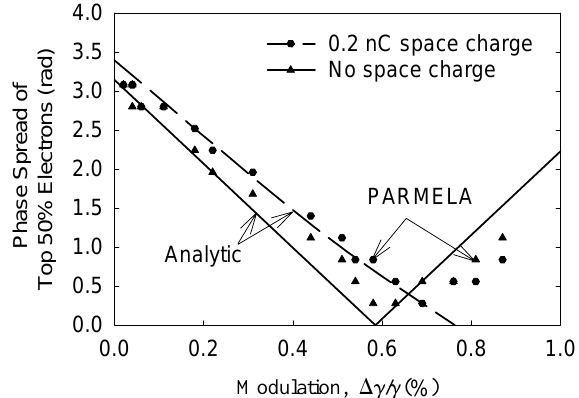
FIG. 6. Comparison between the analytic model and PARMELA code simulations of the phase spread of the top 50% of the electrons in the center of the microbunch. The analytic model is not valid after bunch inversion [see Eq. (19b)] and, therefore, the dashed line stops at this